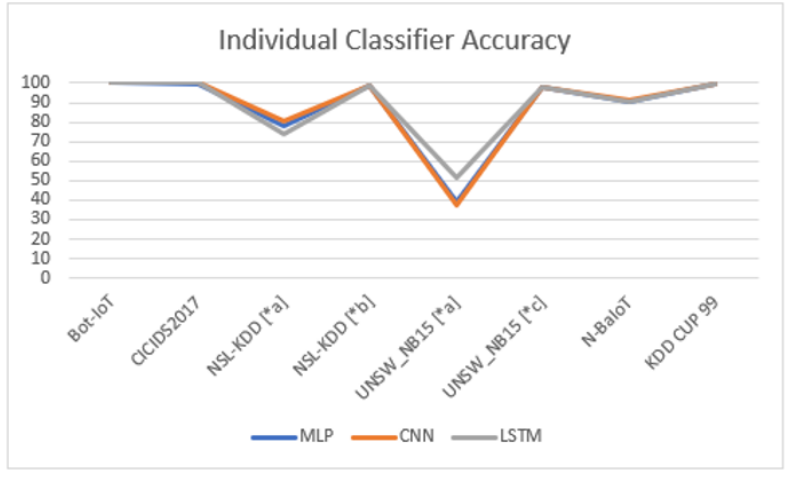
Figure 4. Individual classifier models’